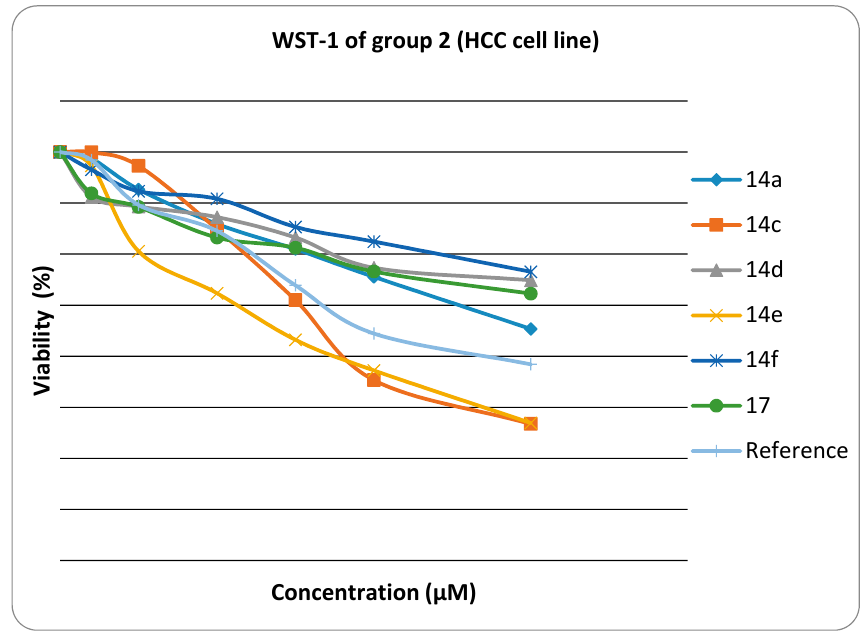
Figure 2. Viability chart of tested Group 2 compounds against HEP G2 cell line.